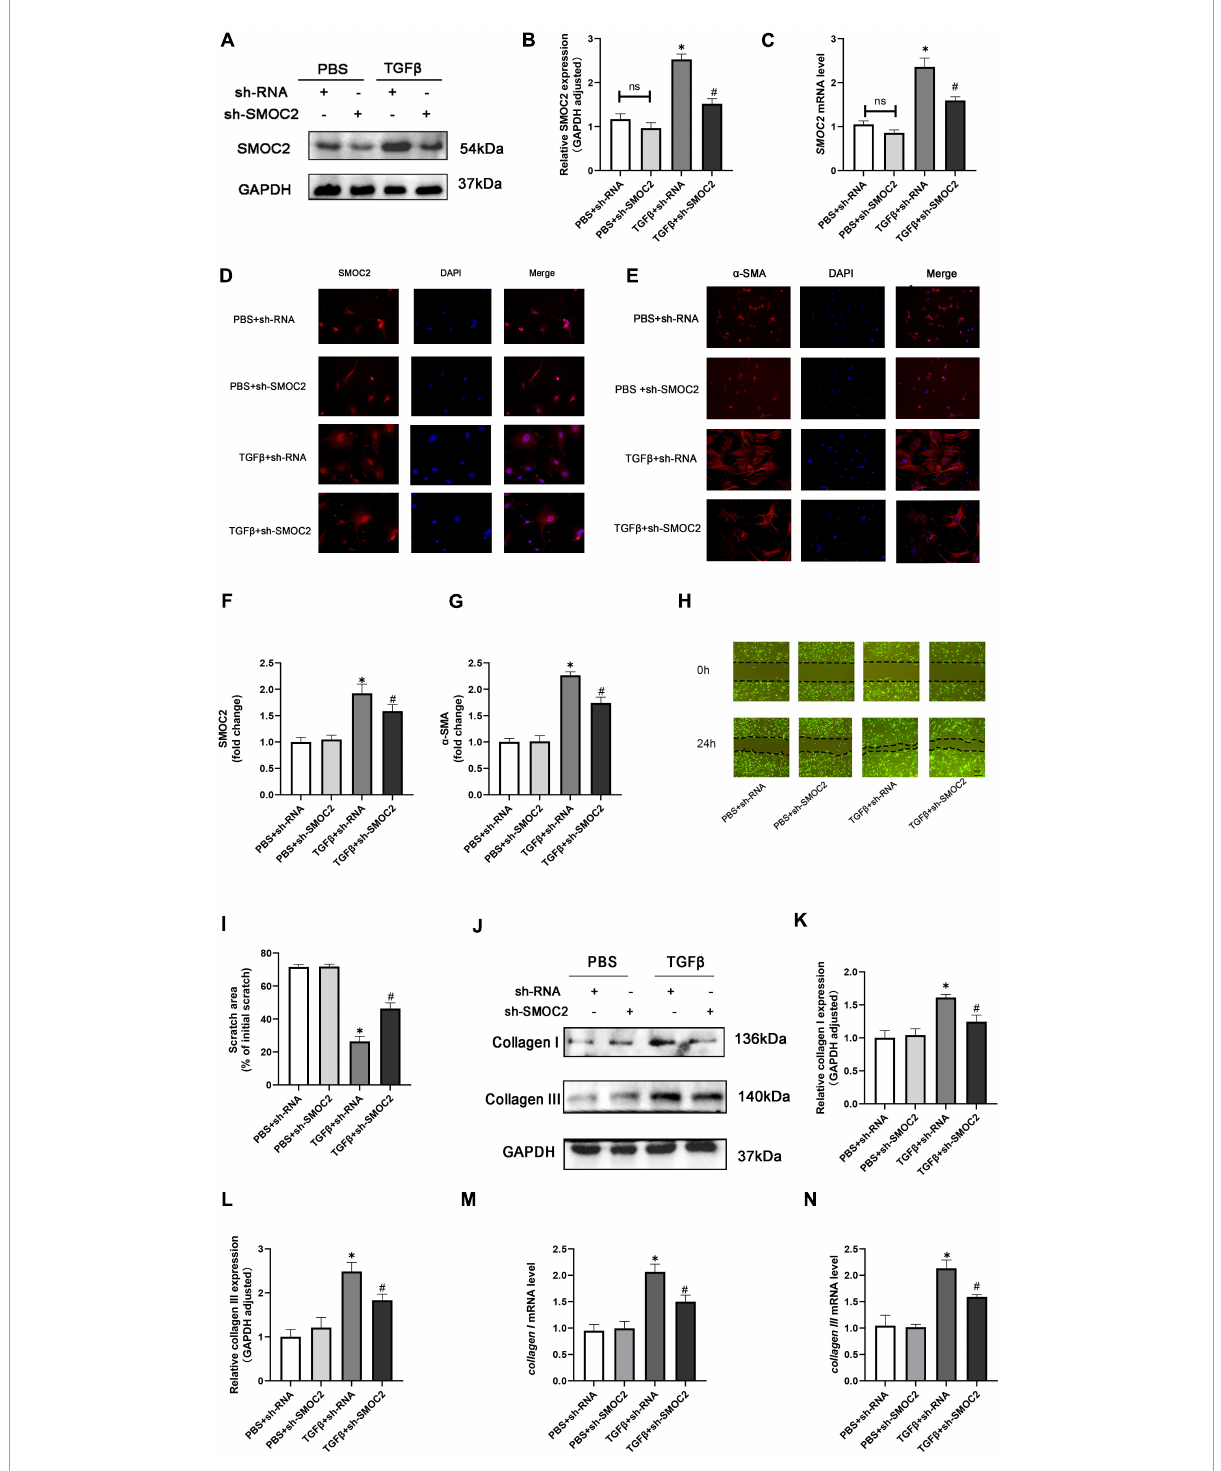
FIGURE6 Targeting SMOC2 expression improves the proliferation, migration, and differentiation and exacerbates fibrosis of fibroblasts in vitro . (A,B) SMOC2 expression after sh-RNA or sh-SMOC2 infection ( n = 6). (C) mRNA levels of SMOC2 after sh-RNA or sh-SMOC2 injection ( n = 6). (D–G) Immunofluorescence staining of SMOC2 and α -SMA for the indicated groups ( n = 6). (H,I) Representative images of the wound scratch assay at 0 and 24 h ( n = 5). (J–N) Collagen I and collagen III expressions after sh-RNA or sh-SMOC2 infection in cardiac fibroblasts ( n = 6). ∗ p < 0.05 vs. the control + sh-RNA group. # p < 0.05 vs. the TGF β + sh-RNA group. n.s.,